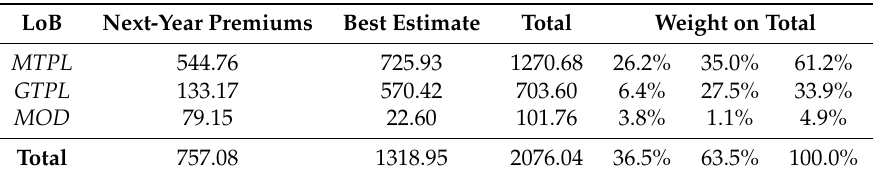
Table 1. Premium and reserve volumes. Amounts in millions of euro.